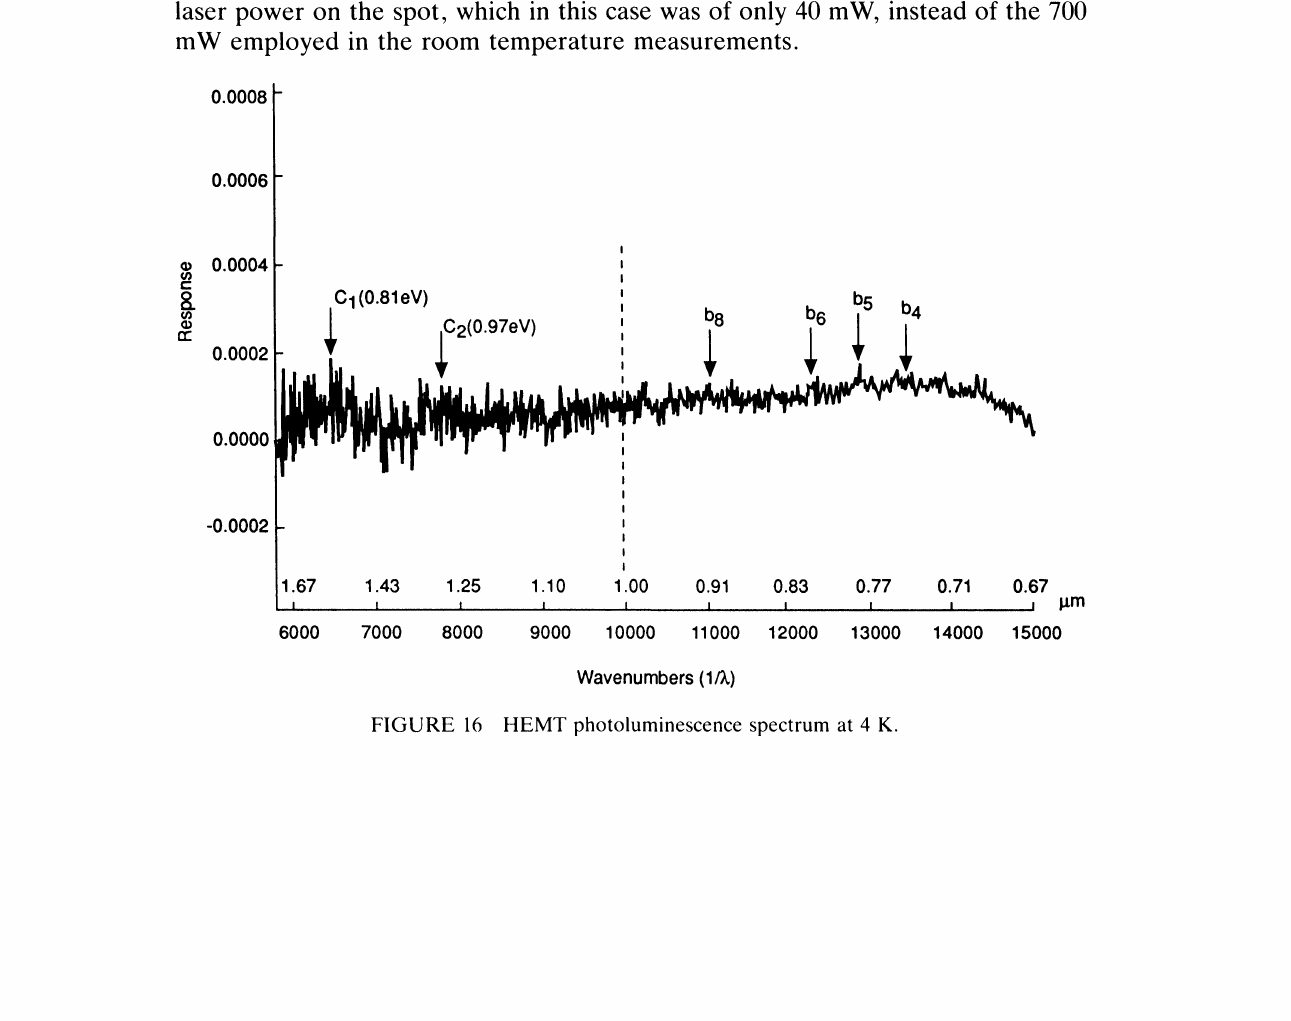
FIGURE 16 HEMT photoluminescence spectrum at 4